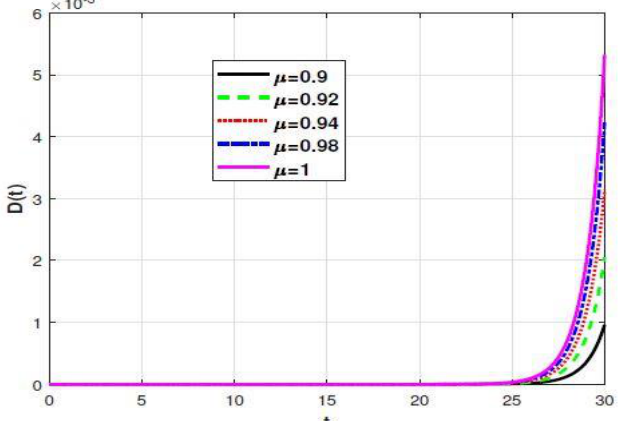
Fig. 3. Numerical experiments of asymptomatic infected class for various value of fractional order